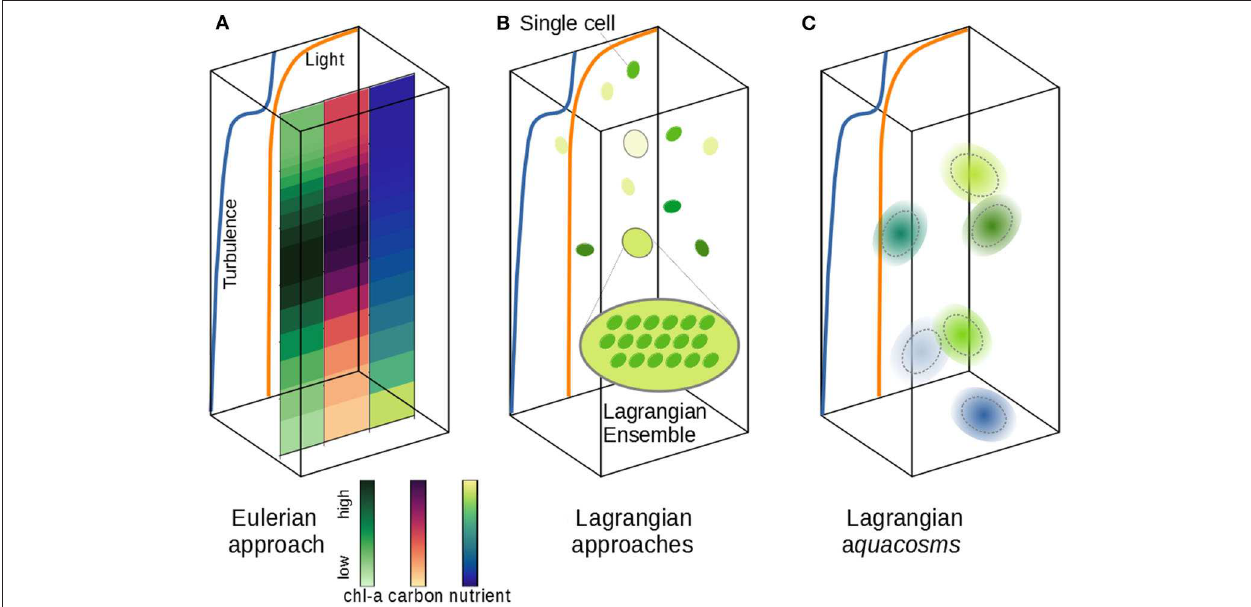
FIGURE 1 | Schematic of different phytoplankton modeling approaches. (A) The vertical distribution of phytoplankton carbon and chlorophyll can be simulated according to vertical nutrient and light gradients and a turbulent field. The Eulerian approach samples all active fields at the nodes of a fixed grid; fine and microscale stirring (turbulence) is modeled as irreversible mixing, wiping out fine, and microscale patchiness. (B) The Lagrangian Ensemble approach bundles individual cells into Lagrangian parcels; the number of organisms per parcel is modified by infra-parcel ecological interactions; unresolved turbulence is modeled as a stochastic motion of the parcels, which don’t interact with each other. (C) The Lagrangian aquacosm approach tracks tiny Lagrangian water masses ( aquacosms ) moving as in (B) ; biogeochemical interactions occur within aquacosms, which are permeable, thus allowing for mass exchanges between nearby